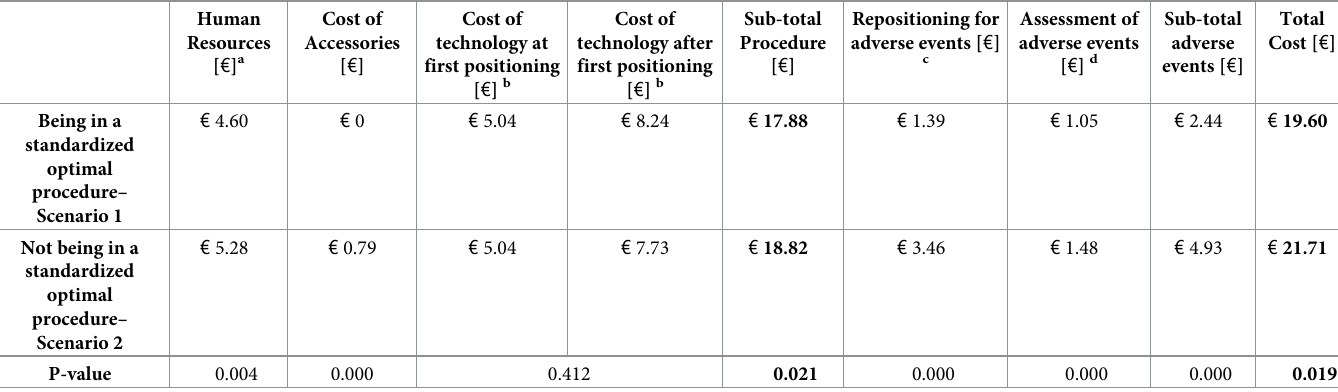
Table 5. Economic evaluation of the process.